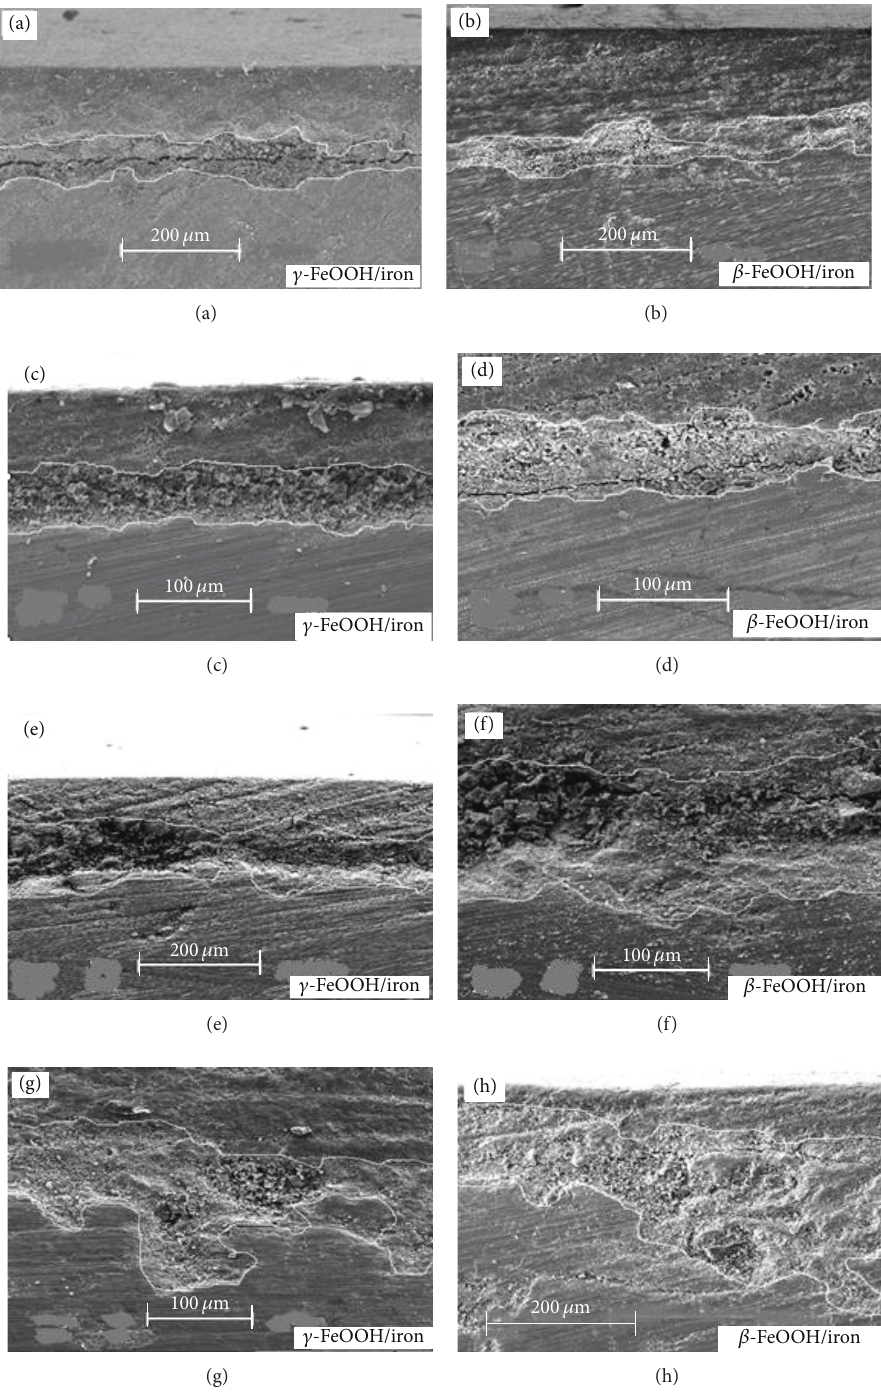
Figure 5: SEM images of rust powder/cast iron interface with the effects of NO 3− ((a) and (b)); Cl − ((c) and (d)); HSO 4− ((e) and (f)); and Cl − +HSO 4− ((g) and